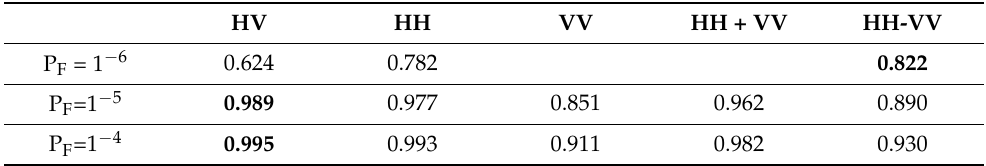
Table 6. Probabilities of detection for intensities open ocean. Bold numbers indicate highest P D